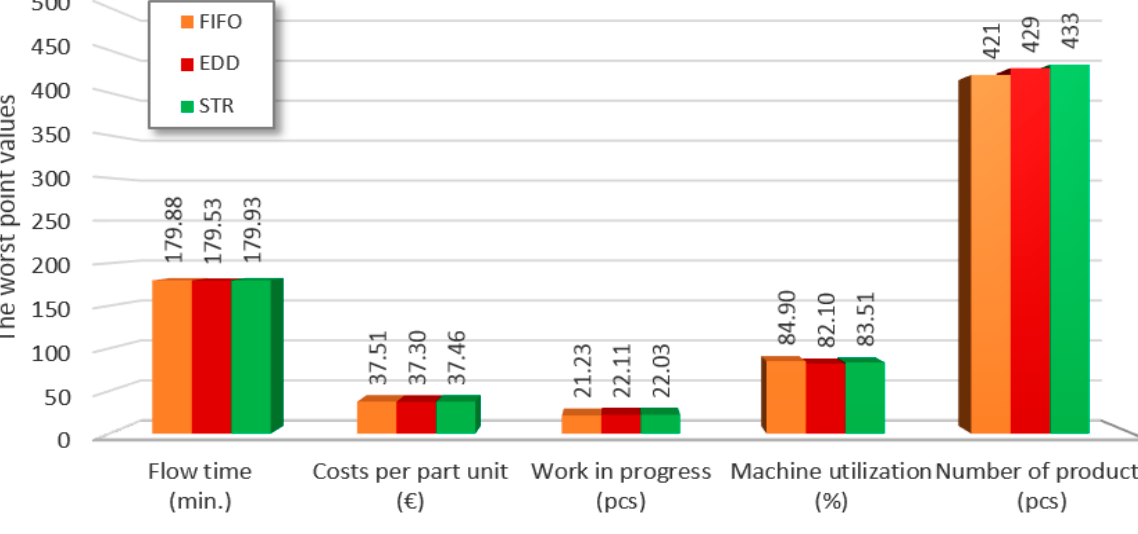
Figure 3. The comparison of the worst point values with respect to different priority rules. Secondly, the experiments focused on multi-criteria optimization carried out to acquire the optimal daily production results according to given a priori preferences. When applying the WPM method, the minimization of objective function regarding the best and worst values of production performance, introduced in Box 2 and subjected to constraints, was performed. On the contrary, the objective function built via WSM scalarization method presented in Box 1 was maximized. In contrast to the approach in the works of Marler and Arora [24] or Xiang et al. [47], where the distance of the solution to the ideal point was minimized, we modified the structure of scalar objective function so that the maximization of the distance between solution and the worst point was